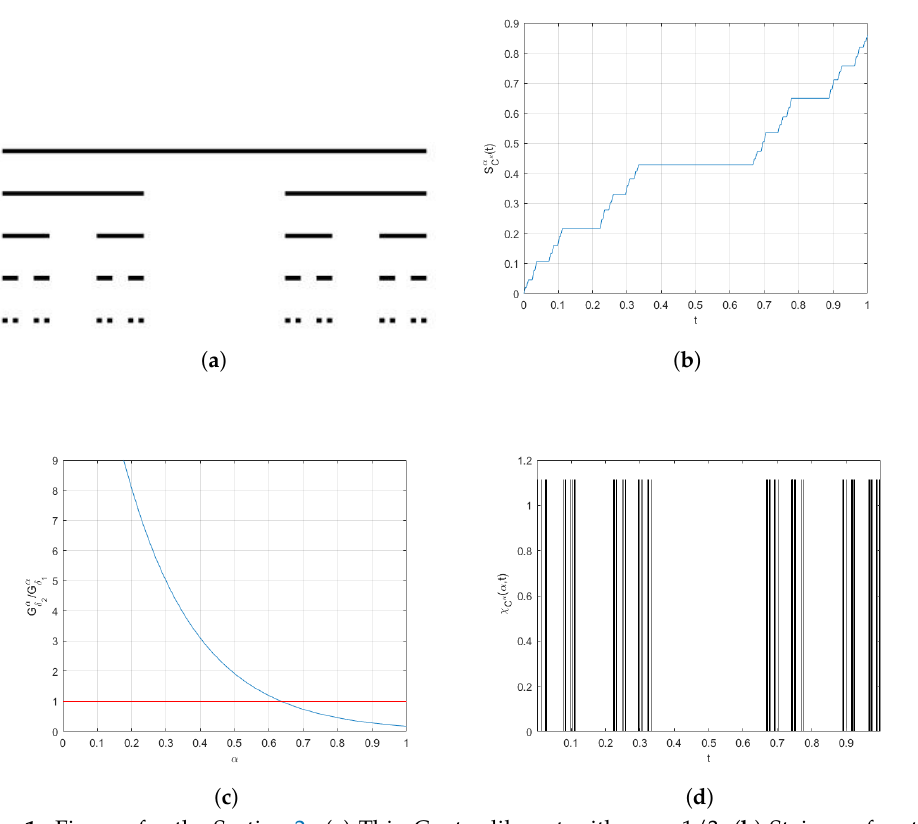
Figure 1. Figures for the Section 2. ( a ) Thin Cantor-like set with ω = 1/3; ( b ) Staircase function corresponding to thin Cantor-like set with ω = 1/3; ( c ) The γ -dimension of thin Cantor-like set with ω = 1/3; ( d ) Characteristic function for Cantor-like set with ω =